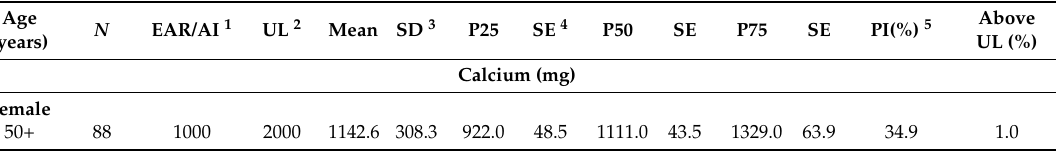
Table 2. Selected results from the mean distribution and percentiles for usual intake, prevalence of inadequate intake, and percentage of individuals above tolerable upper intake levels value by gender and age. Brazil,